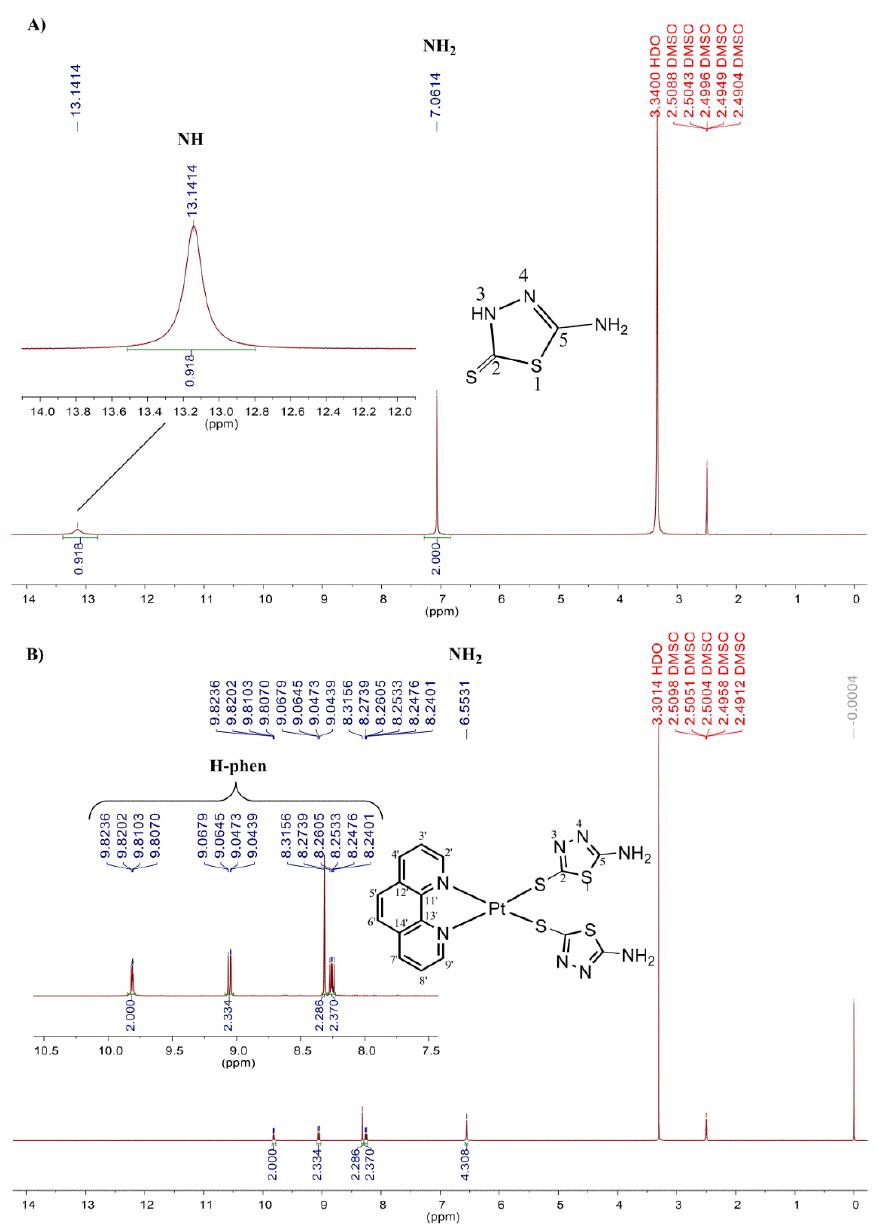
Figure 2. 1 H NMR spectrum (DMSO- d 6 , 400 MHz) of the ligand 5-amino-1,3,4-thiadiazole-2(3H)- thione with expansion from 12–14 ppm ( A ) and of the complex I expanded from 7.5–10.5 ppm (region assigned to hydrogens of the phenanthroline) ( B